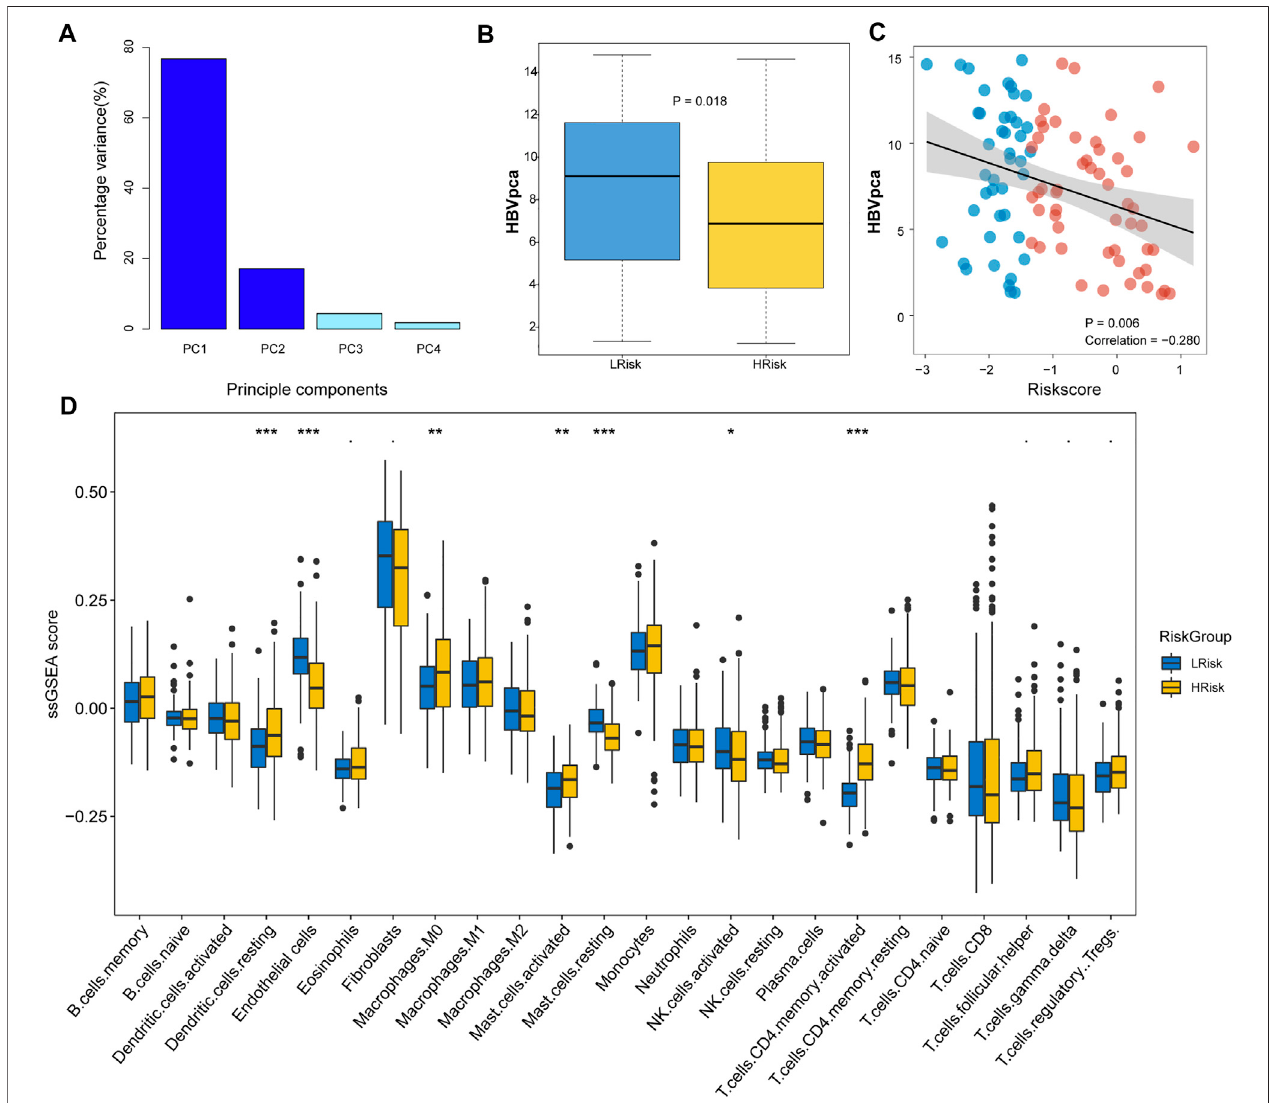
FIGURE 4 | Immune in fi ltration and HBV pca score between HRisk and LRisk group in TCGA cohort. (A) Barplots showing that the fi rst and second principal components present almost all the variations with a summing percentage of 93.83%. (B) Boxplot showing HBV pca difference in the HRisk and LRisk groups (Wilcoxon test, p = 0.018). (C) Spearman correlation analysisbetween HBV pca and riskscore ( R = -0.280, p =0.006). (D) Boxplot for TCGA cohort showing the enrichment level of 24microenvironmentcelltypesbetweenHRisk(yellow)andLRisk(blue)groups.Statistical p valueswerecalculatedbytheWilcoxontestandrepresentedby. < 0.1, * < 0.05, ** < 0.01, and *** <